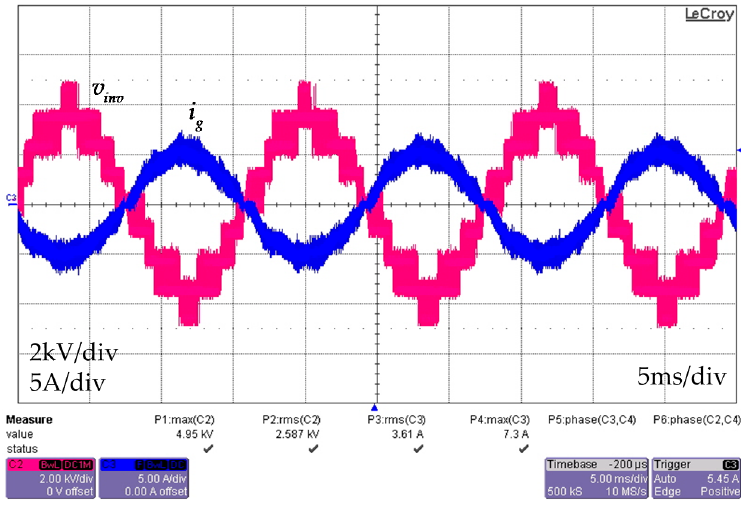
Figure 19. The switching voltage and the input current of the AFE converter cascaded in two modules.